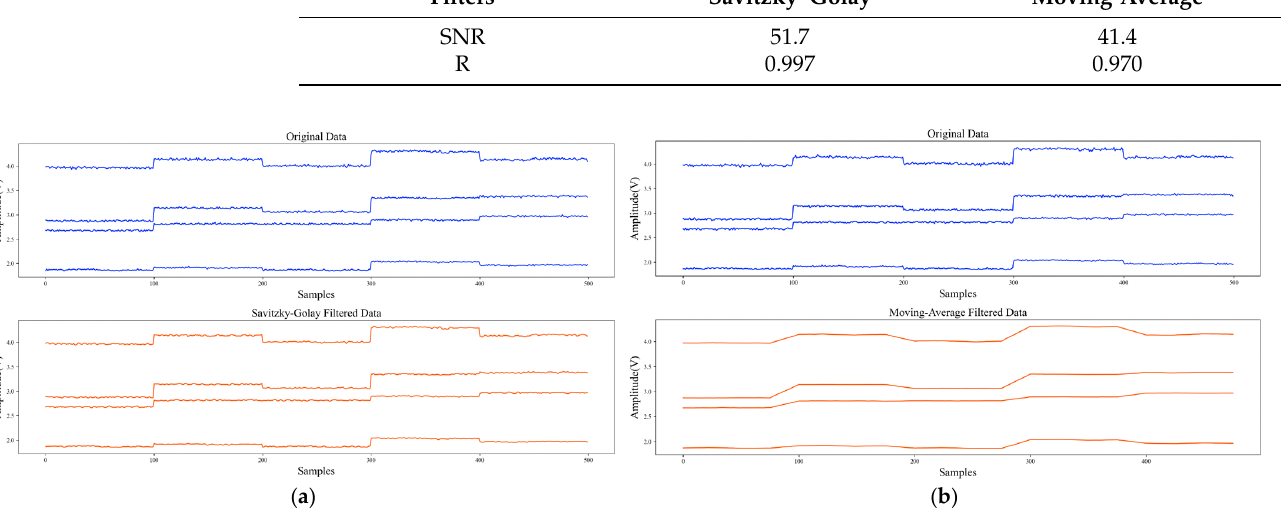
Figure 9. Original data and filtered data: ( a ) Signal waveforms before and after Savitzky–Golay filtering; ( b ) Signal waveforms before and after Moving-Average filtering. Table 3. Comparison of different filters.